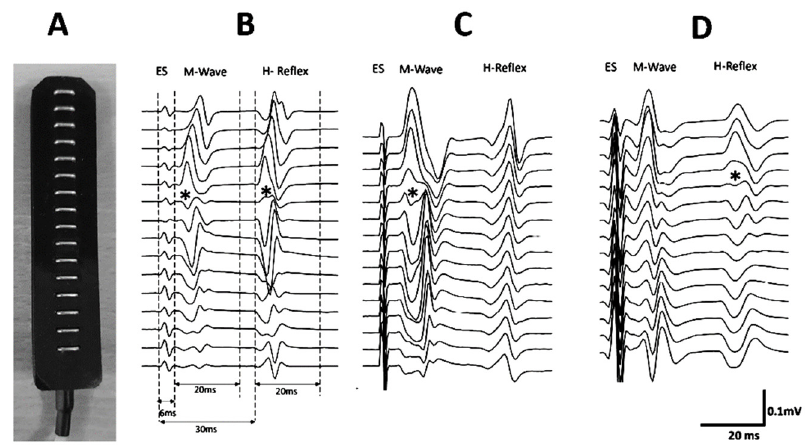
Figure 2. A linear array of 16 electrodes was used ( A ). Examples of locations of innervation zones (IZ) of the medial gastrocnemius muscle for one volunteer. The innervation zones are shown with (*) ( B ). The windows in which the EMG amplitudes of the M-wave and H-reflex were calculated are shown. ( C ) An IZ is observed in the M-wave but not in the H-reflex. ( D ) An IZ is seen in the H-reflex but not in the M-wave.